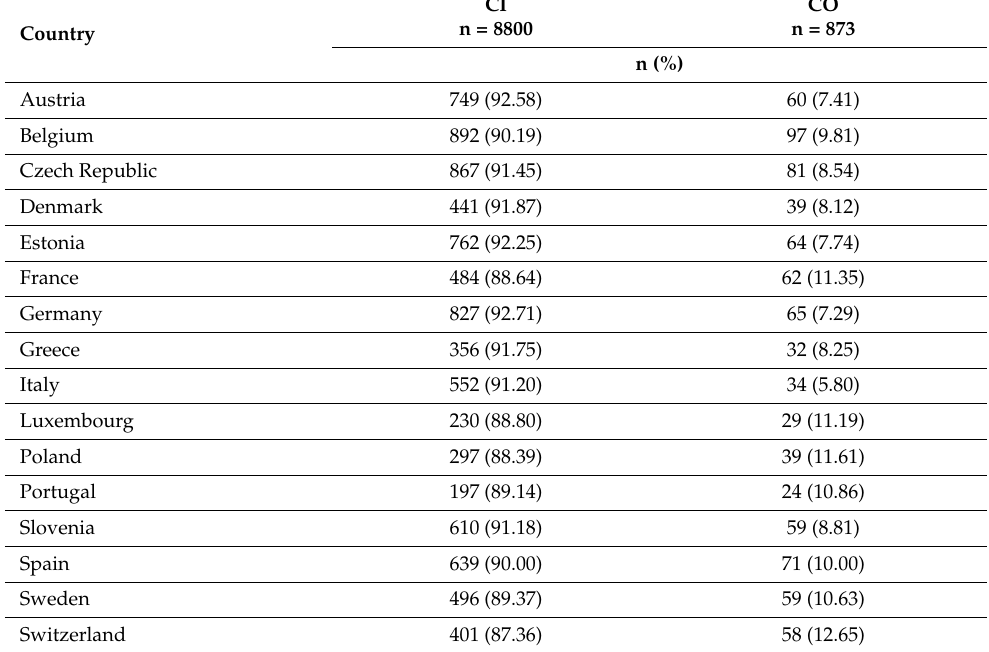
Table 2. Hospital cost outliers (CO) and inliers (CI) by country.